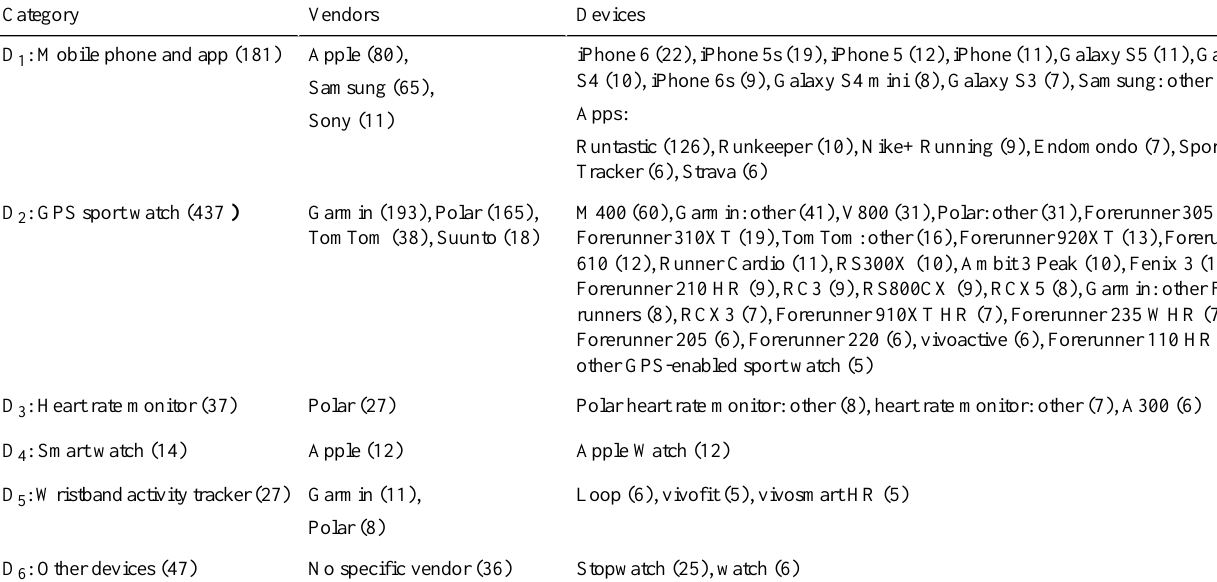
Table 2. Device categories, vendors, models, and apps used by runners. Only vendors, devices, and apps with ≥ 5 occurrences collected with Q 1 are listed. Values in curved brackets represent the number of mentions for the respective category, vendor, device, or app.